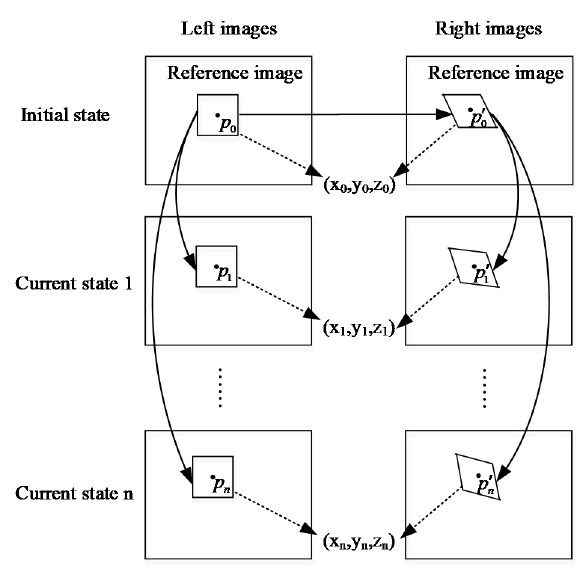
Figure 5. A schematic overview of three-dimensional digital image correlation (3D-DIC).